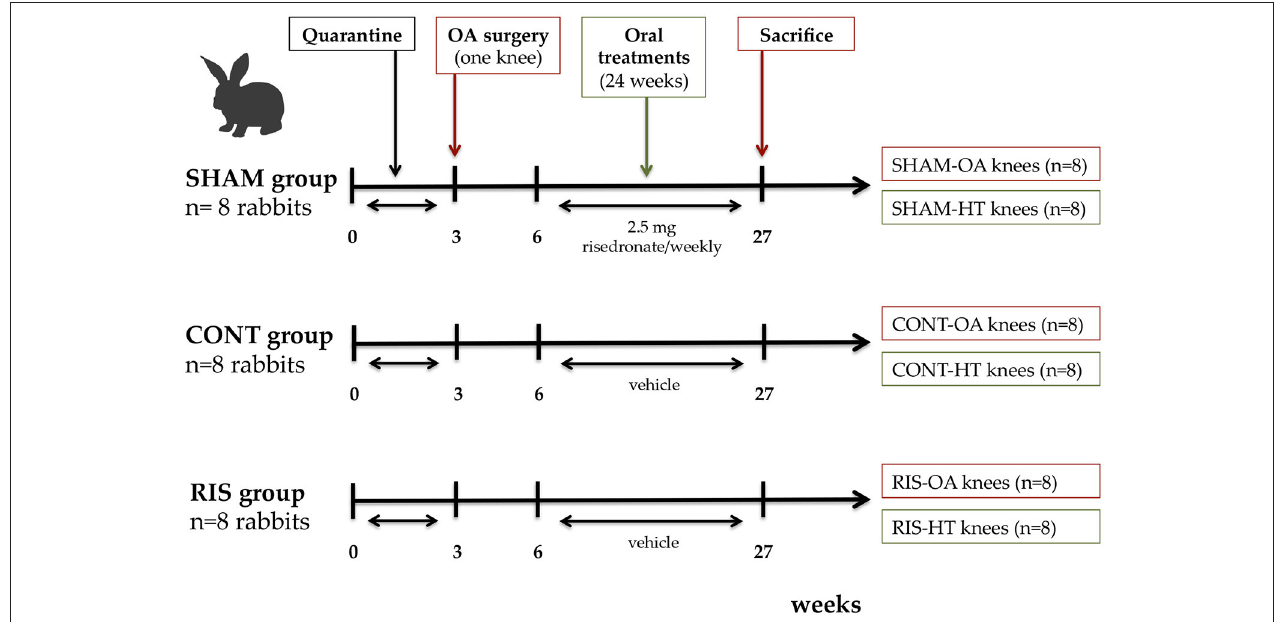
FIGURE 1 | Diagram showing the schedule of the experimental design. SHAM group, surgery control group; CONT group, placebo treated group; RIS group, risedronate treated group; OA knee, operated osteoarthritic knee; HT knee, healthy contralateral